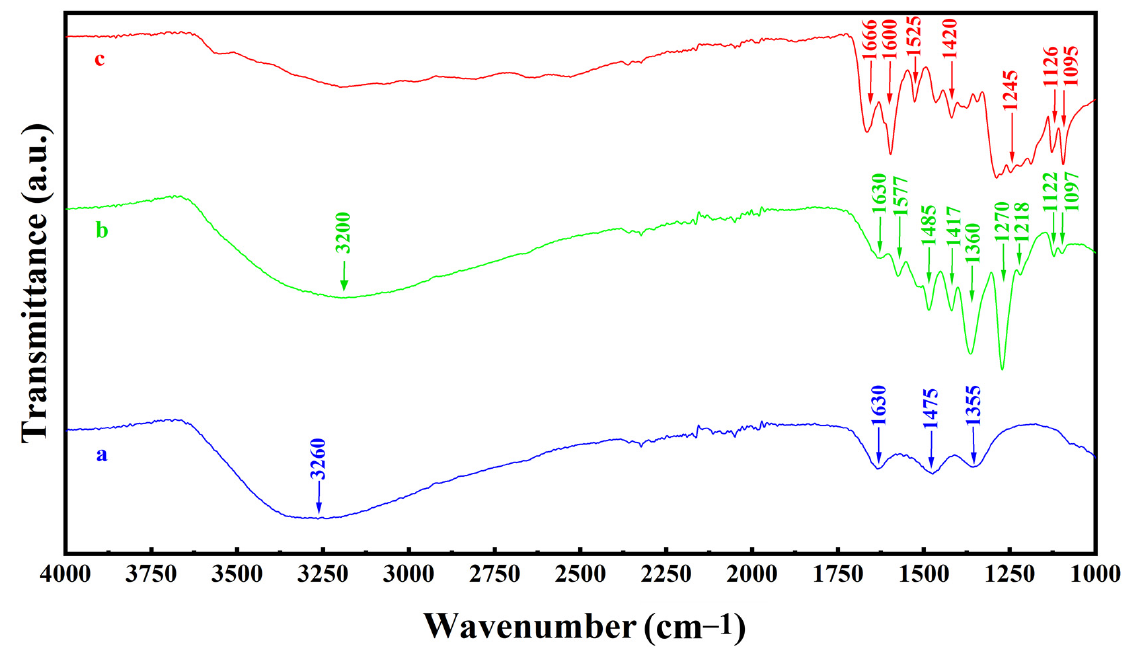
Figure 3. FTIR spectra of (a) Fe 3 O 4 prepared without DHBA, (b) Fe 3 O 4 prepared using DHBA, and (c) pure as-received DHBA.